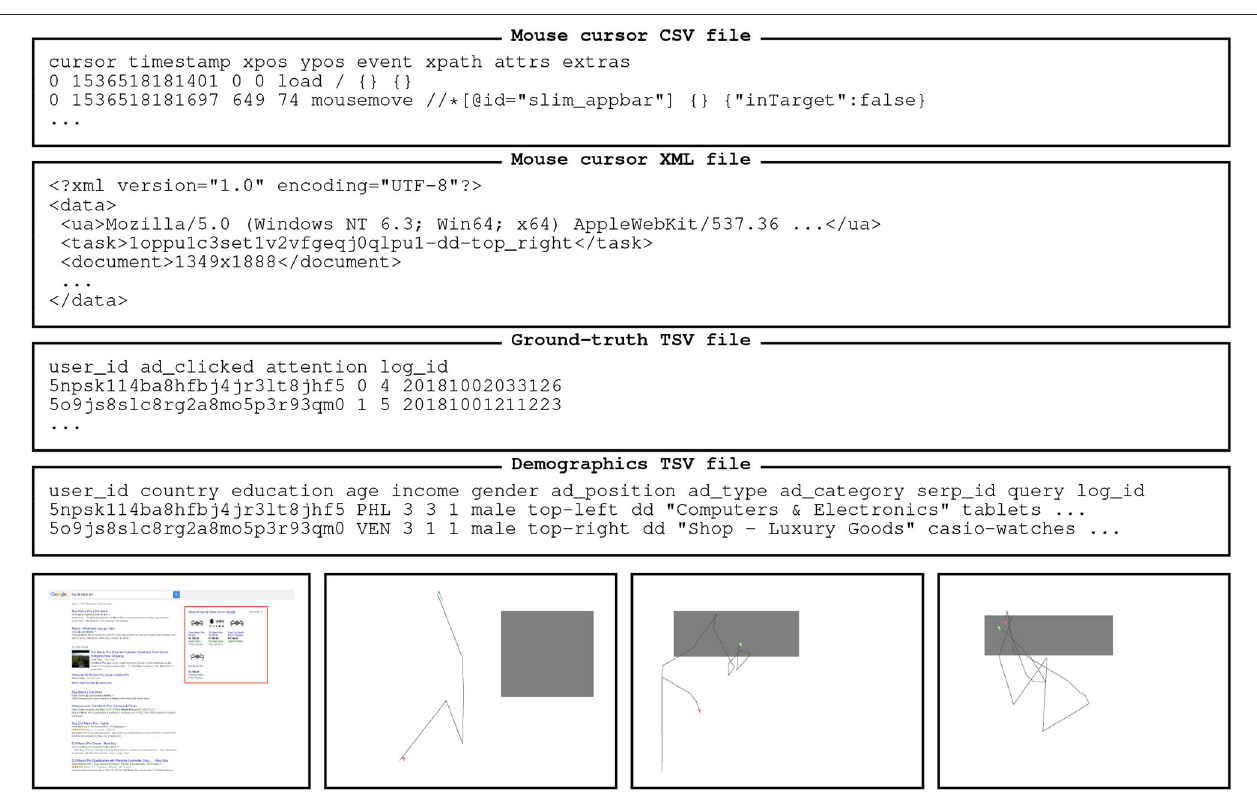
FIGURE 1 | File content samples (top) and SERP snapshots with mouse cursor trajectories (bottom). An ellipsis ( ... ) denotes an intentional omission of some data, for brevity’s sake. The gray-colored rectangles in the bottommost figures denote the different ad types, from left to right: right-aligned bundled ad, left-aligned bundled ad, and native